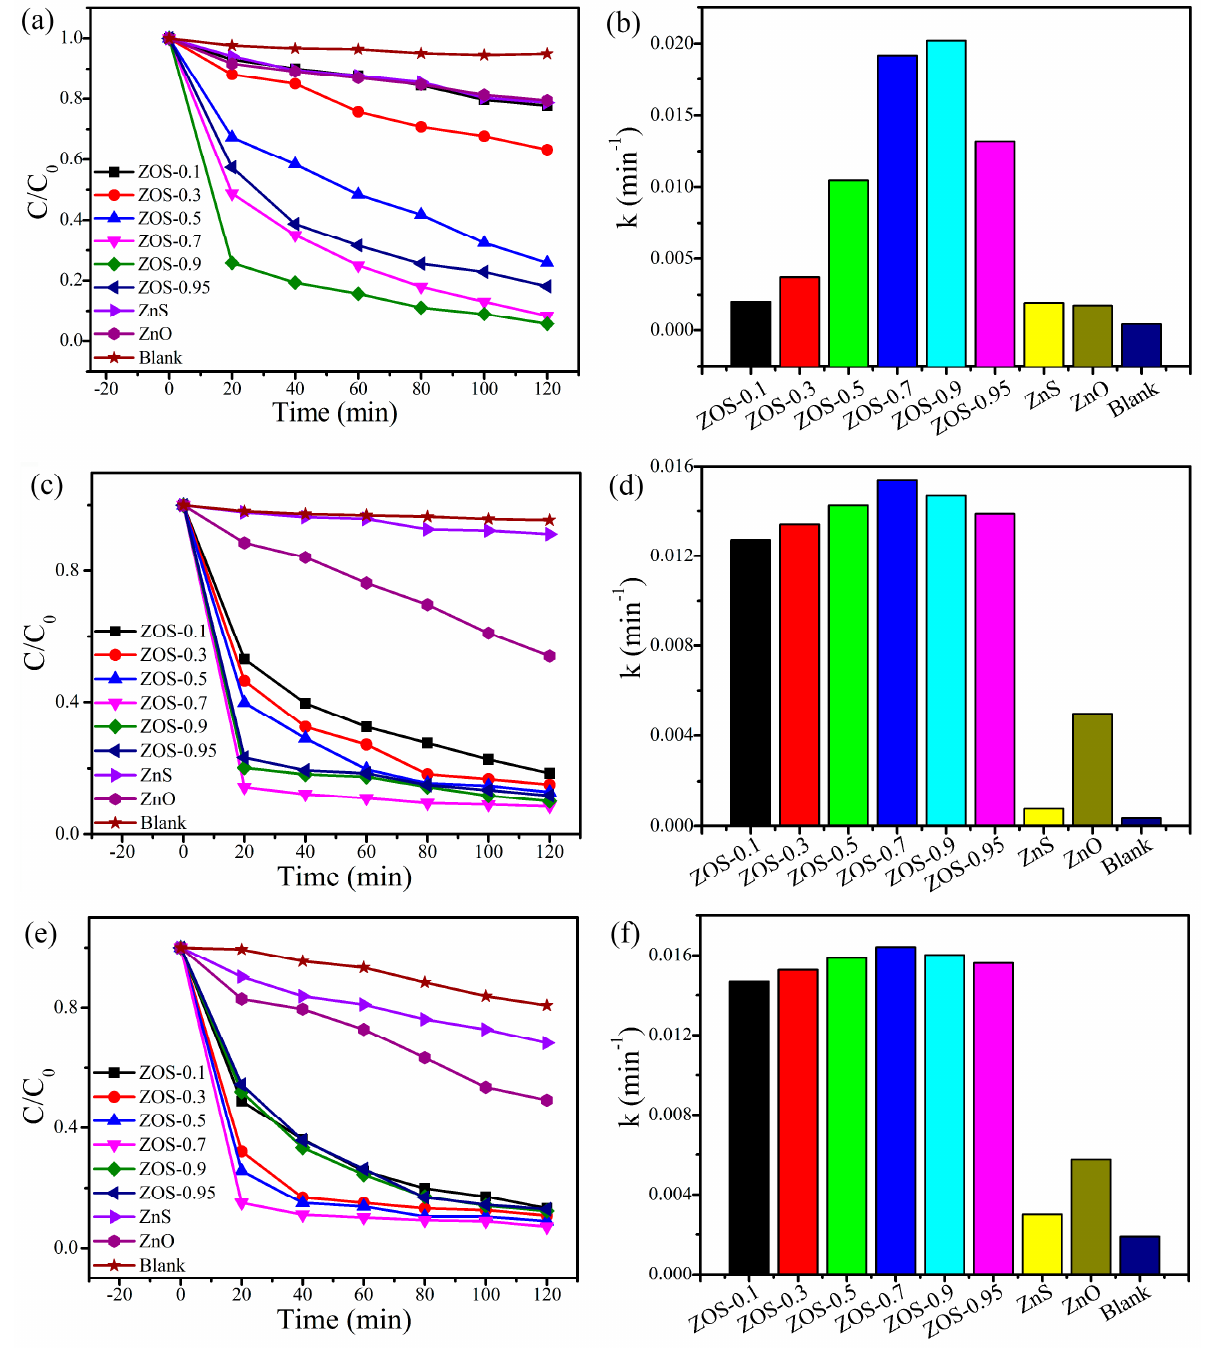
Figure 6. Photodegradation rates and kinetic curves under UV light for the degradation of MO ( a , b ), RhB ( c , d ), and tetracycline ( e , f ) over ZnO, ZnS, and ZnO/ZnS photocatalysts. The photocatalytic performance of ZnO/ZnS photocatalyst for tetracycline was further studied. In Figure 6e, 32% of tetracycline was degraded by ZnS after 120 min of UV light irradiation, while the degradation rate of tetracycline by ZOS-0.7 reached 93%, which was higher than that the reported [47]. It can be seen that the photocatalyst ZOS-0.7 can basically completely degrade the tetracycline, indicating that the photocatalyst ZOS-0.7